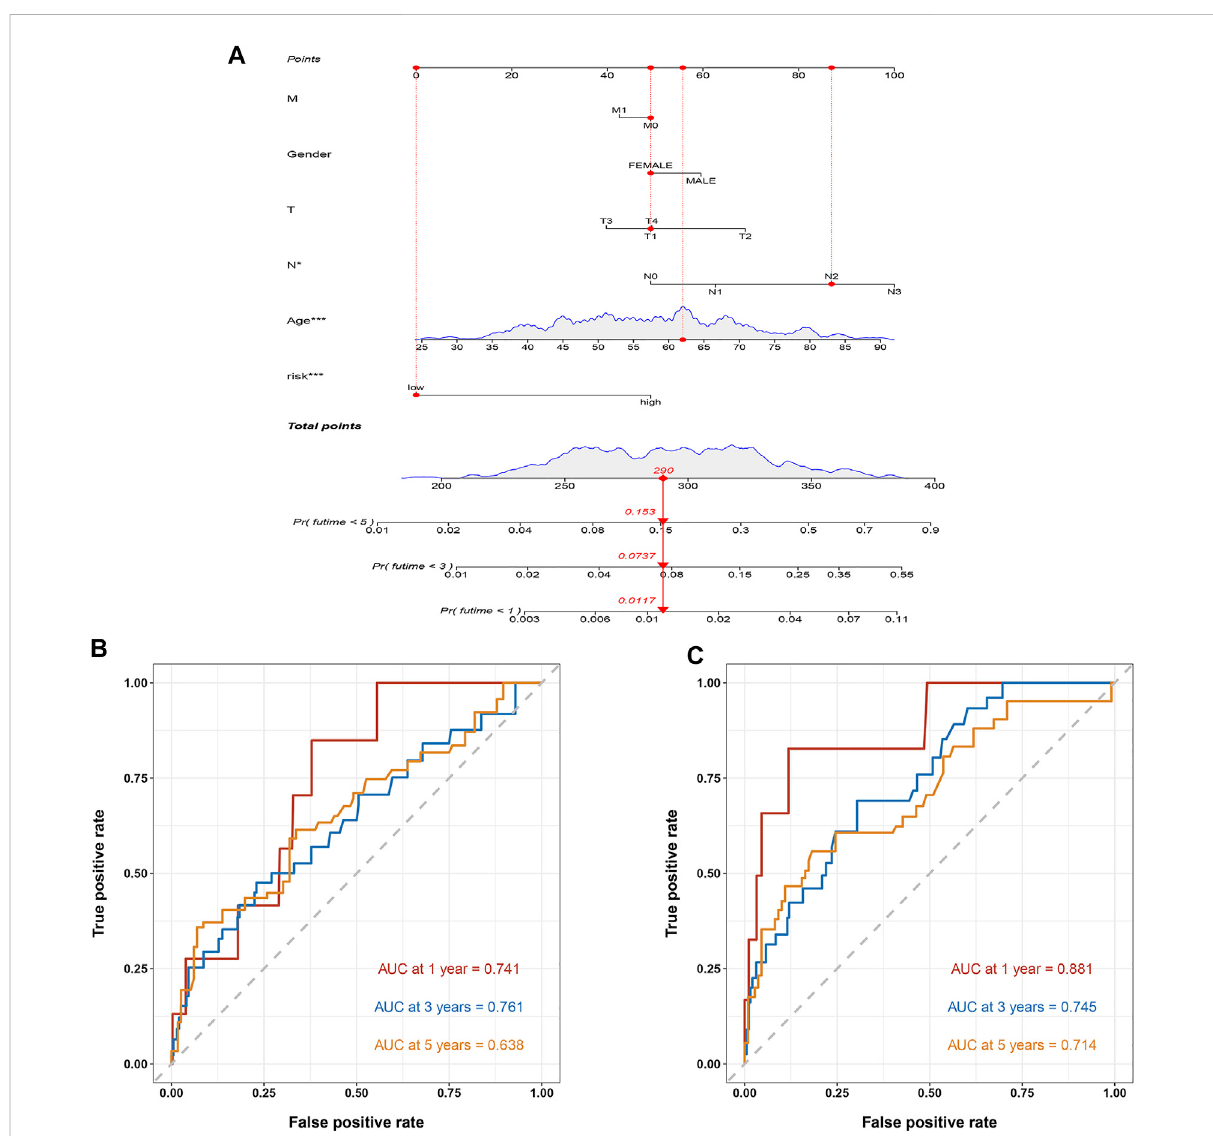
FIGURE 9 The construction of a nomogram. (A) The nomogram. The mortality rate of the patient in 1, 3, and 5 years was estimated to be 0.0117, 0.0737, and 0.153. (B) ROC curve of the nomogram in the training cohort. The AUC in 1, 3, and 5 years were 0.741, 0.761, and 0.638, respectively. (C) ROC curve of the nomogram in the test cohort. The AUC in 1, 3, and 5 years were 0.881, 0.745, and 0.714,